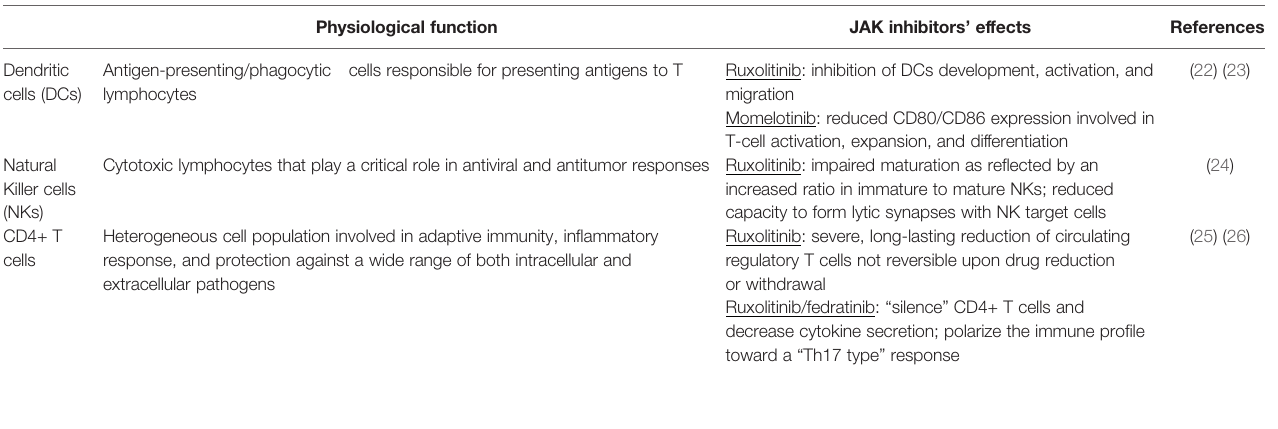
TABLE 1 | Immune system components and JAK inhibitors ’